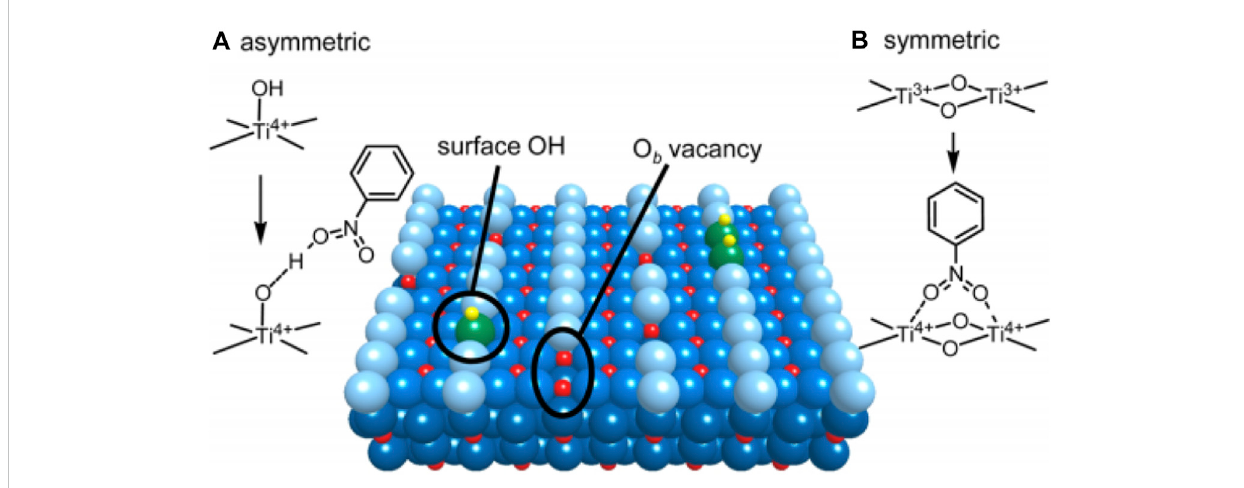
FIGURE 1 Surface structure of rutile TiO 2 (Yang et al., 2022). (A) Asymmetric adsorption mode of nitrobenzene, and (B) symmetric adsorption mode of nitrobenzene. Green and light blue spheres: O b atom at [001] azimuth; yellow and red spheres: H and Ti atoms. Reproduced with permission from reference (Shiraishi et al.,